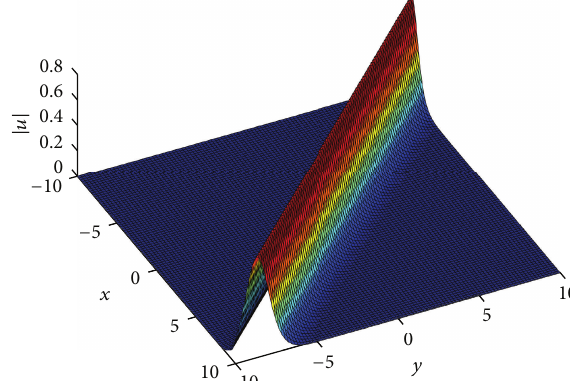
Figure 7: Interaction of two solitons |𝜓| 2 and |𝜙| 2 at 𝑡 = 0 .